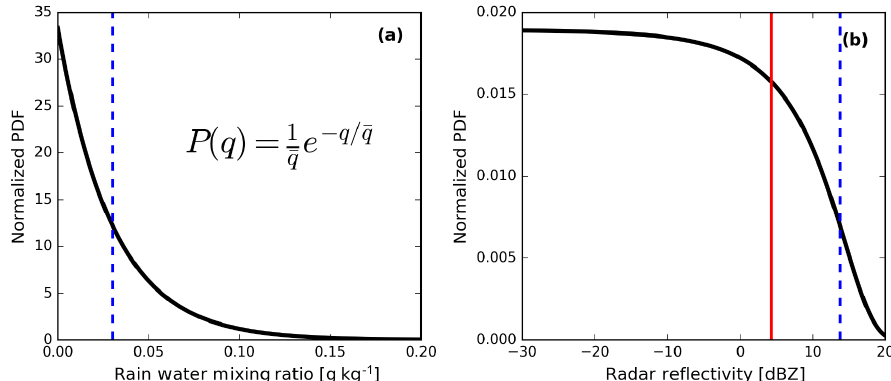
Figure 1. (a) PDF of the rainwater mixing ratio for rainwater when the horizontal variability of rainwater is assumed to follow the exponential distribution. The vertical dashed blue line indicates the mean value of the rainwater mixing ratio as 0.03gkg − 1 . (b) The corresponding PDF of the CloudSat radar reflectivity simulated by COSP assuming the Marshall and Palmer particle size distribution. The dashed blue line corresponds to the radar reflectivity based on the mean rainwater 0.03gkg − 1 , and the solid red line corresponds to the grid-mean radar reflectivity based on the PDF of the rainwater mixing